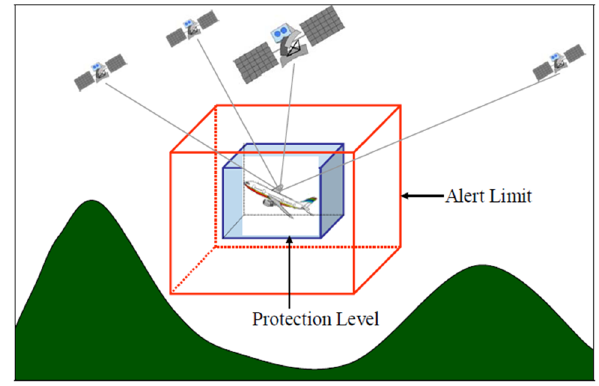
Figure 4: Protection Levels and Alert Limit representation ( Lee, 2005 )